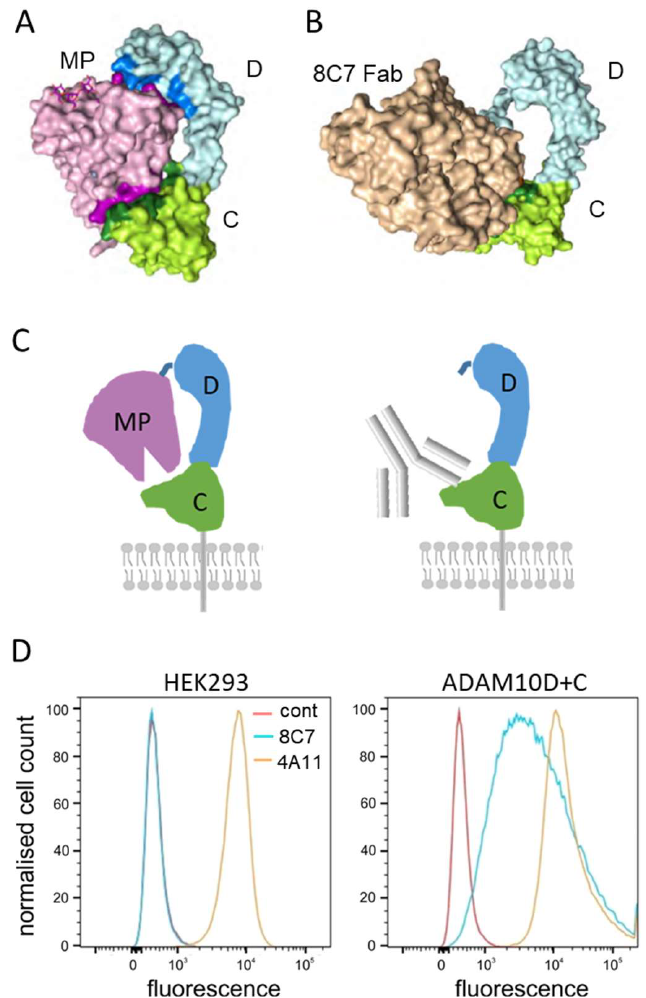
Figure 3. Binding of 8C7 to ADAM10 is sterically regulated by the metalloprotease domain obstructing the 8C7 epitope. ( A ) Crystal structure of the ADAM10 metalloprotease (MP), disintegrin (D) and cysteine-rich (C) domains [13]. ( B ) Crystal structure of the ADAM10 D and C domains in complex with the 8C7 Fab fragment [20]. ( C ) Cartoons of the structures in A and B, illustrating our approach to test whether removal of the MP domain allows binding of 8C7 to ADAM10, using ADAM10 D and C domains lacking the MP domain (ADAM10D + C), expressed on the cell surface. ( D ) HEK293 cells expressing endogenous ADAM10 were transfected with ADAM10D + C and compared to untransfected cells by flow cytometry for binding to the anti-ADAM10 mAbs 8C7 (blue) and 4A11 (yellow), or unstained cells (control, red). A and B were adapted with permission from Seegar et al. 2017, Cell [13].